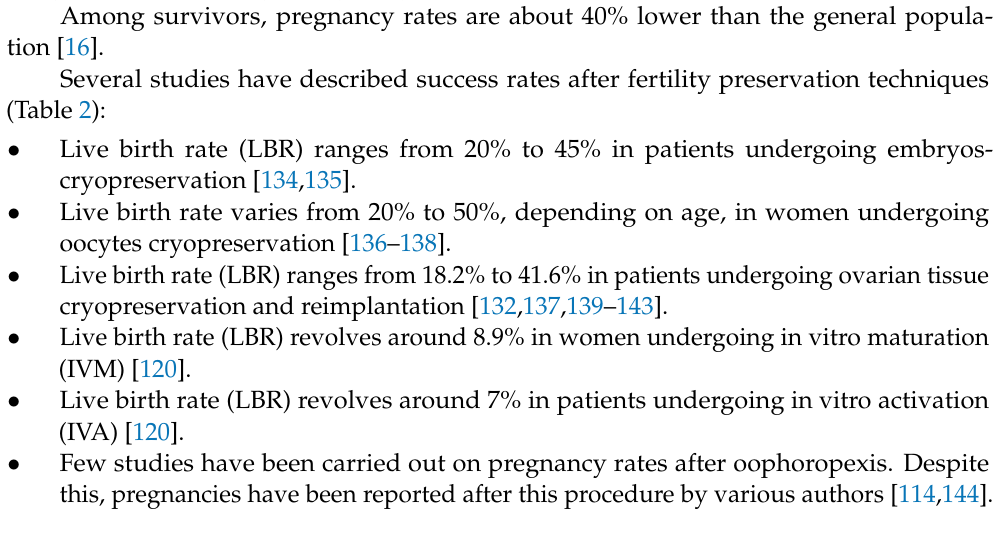
Table 2. Live birth rate after fertility preservation techniques. Techniques